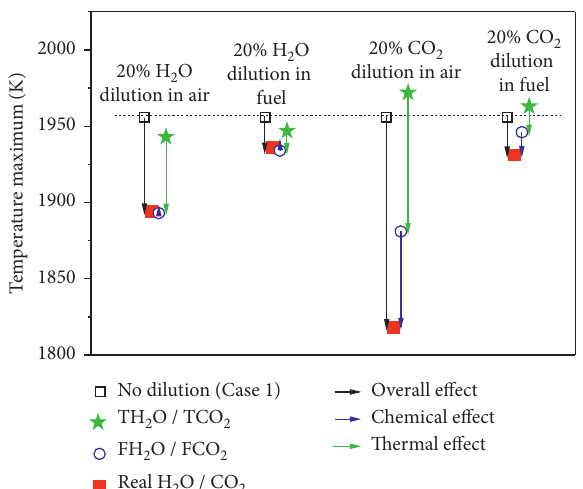
Figure 4: The overall and individual effects of 20% CO 2 and 20% H 2 O dilution on the peak flame temperature of CH 4 /air counterflow diffusion flame: a s � 50 s − 1 , L � 2cm, 400K.